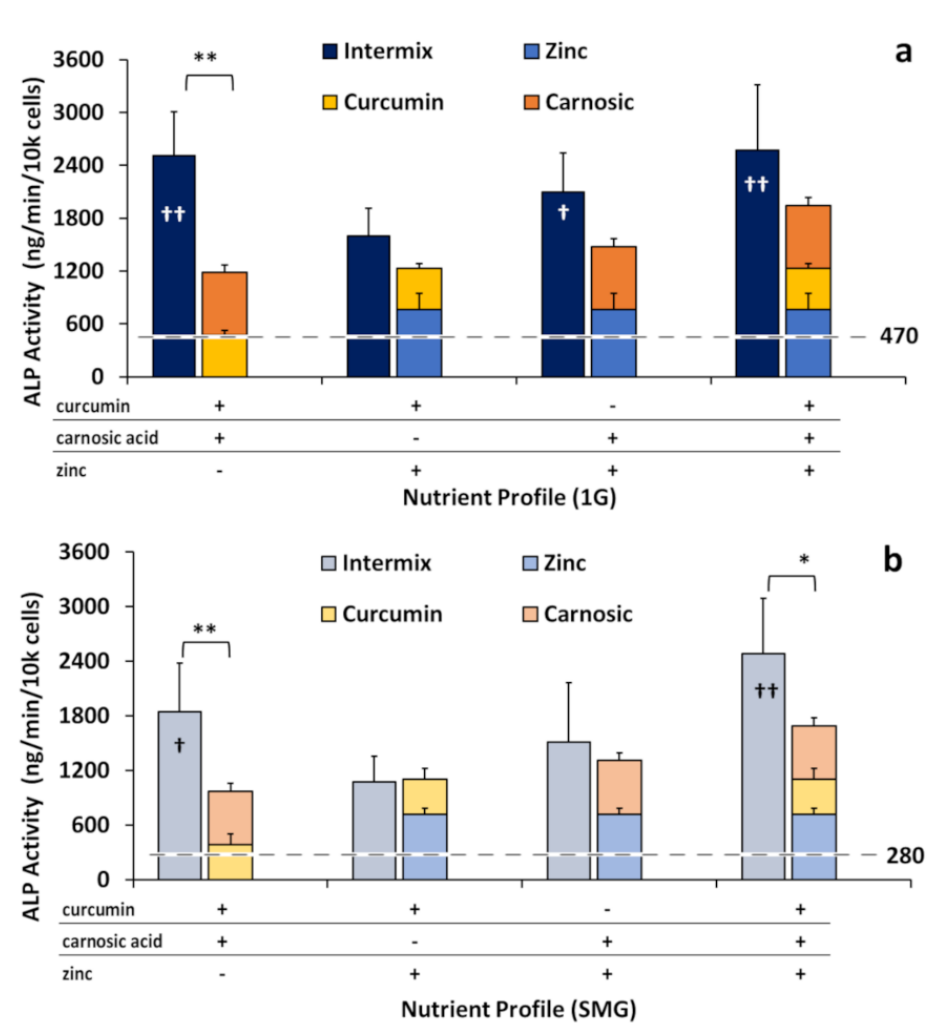
Figure 4. ALP activity normalized by cell number, with ALP activity hypothetically stacked additively versus observed in intermixes. Intermixes are 3.75 µ M curcumin + 12.5 µ M carnosic acid, 3.75 µ M curcumin + 25 µ M zinc, 12.5 µ M carnosic acid + 25 µ M zinc, and 3.75 µ M curcumin + 12.5 µ M carnosic Acid + 25 µ M zinc. ( a ) 1G; ( b ) SMG. The dotted lines represent the levels of normal ALP activity in either 1G ( a ) or SMG ( b ). Asterisk (*) p < 0.05, (**) p < 0.01; Cross (†) p < 0.05, (††) p < 0.01, versus 1G controls. The results reflect means ± SD from three independent experiments ( n = 3 biological